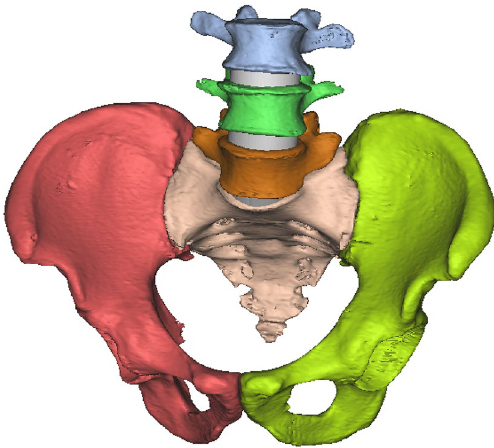
Figure 1. Finite element model generation based on CT